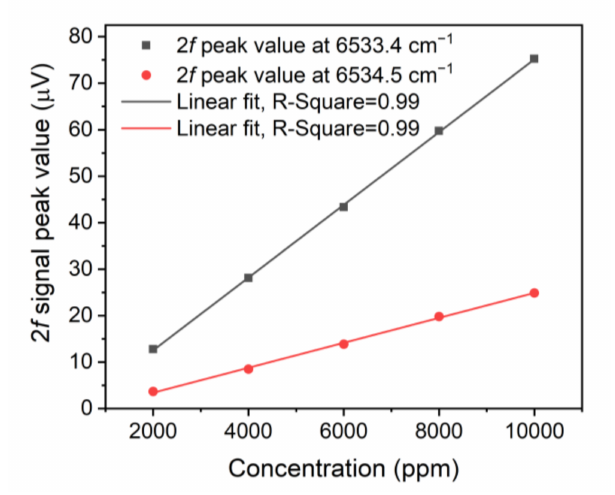
Figure 9. Linear fits of 2 f signal peak values and NH 3